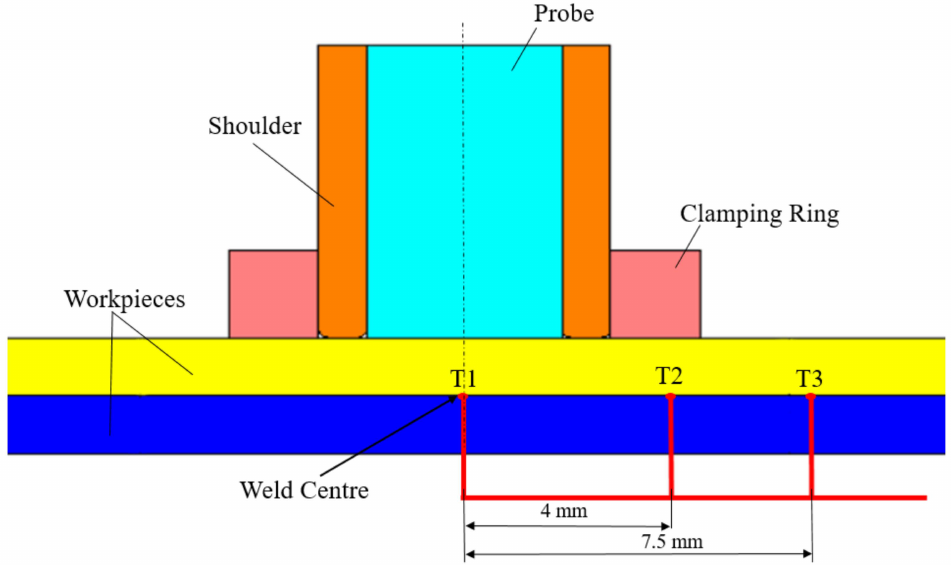
Figure 3. Thermocouple locations for temperature calculation during the